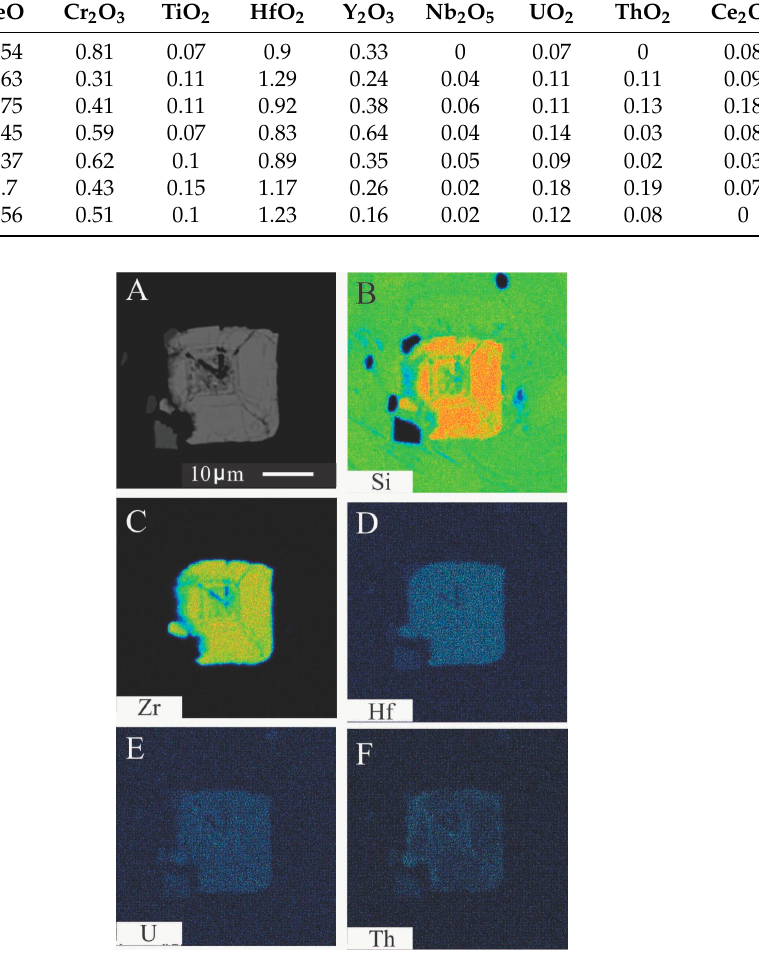
Figure 9. ( A ) Zircon BSE image; ( B – F ) Elemental distribution map.